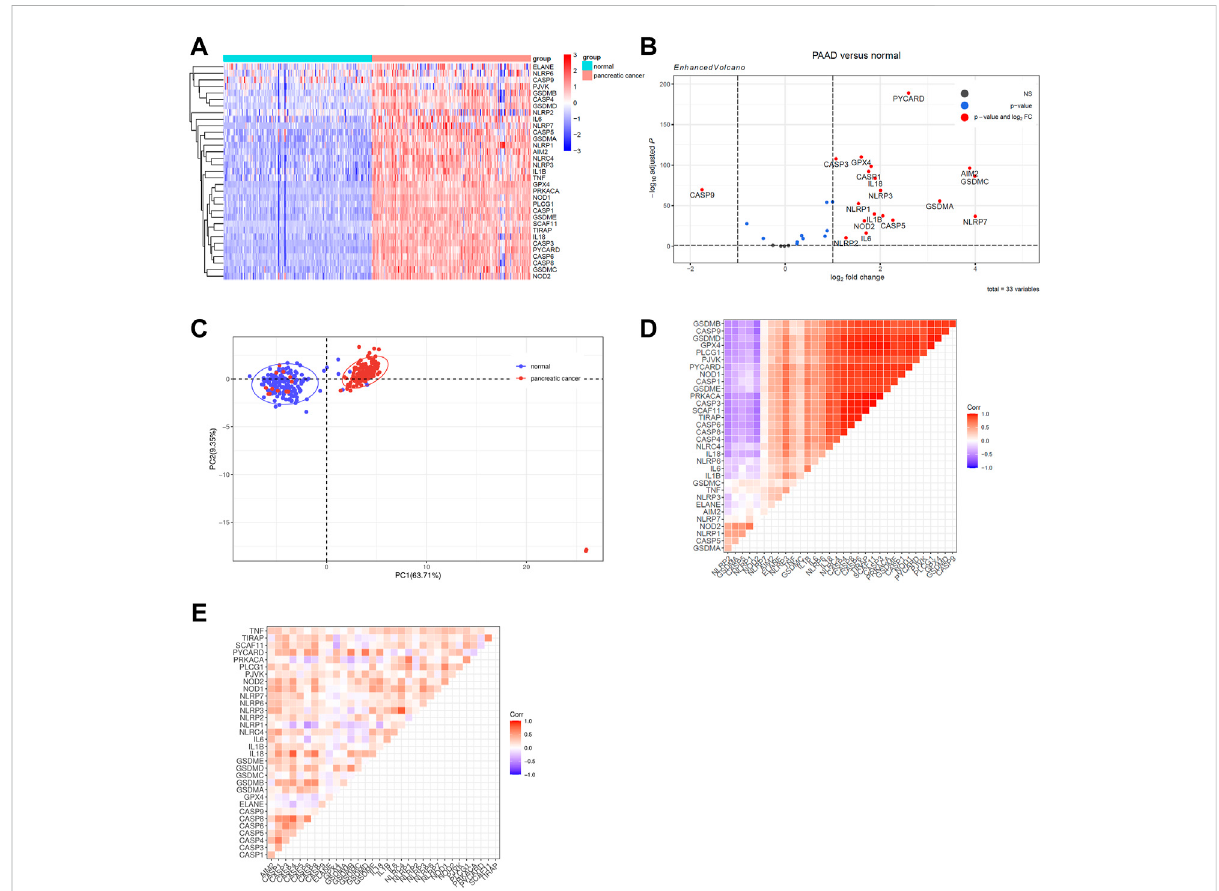
FIGURE 2 Identify differentially expressed PRGs between PAAD and normal pancreatic tissue. Genes with |log2 fold change (log2FC) | > 1 and adjusted p value < 0.05 were considered as differentially expressed genes. (A) A heatmap to show PRGs expression within normal tissue (FPKM data from GTEx cohort) and PAAD tissue (FPKM data from TCGA cohort). (B) The Volcano plot created using the “ Enhanced Volcano ” R package to show differently expressedPRGs. (C) Principal componentanalysis wasprocessed to identify PRGsexpressioncharacters between thenormalpancreatic tissue and the PAAD tissue. (D) A heatmap of correlation matrix of the PRGs within normal tissue from GTEx cohort. (E) A heatmap of correlation matrix of the PRGs within PAAD tissue from TCGA